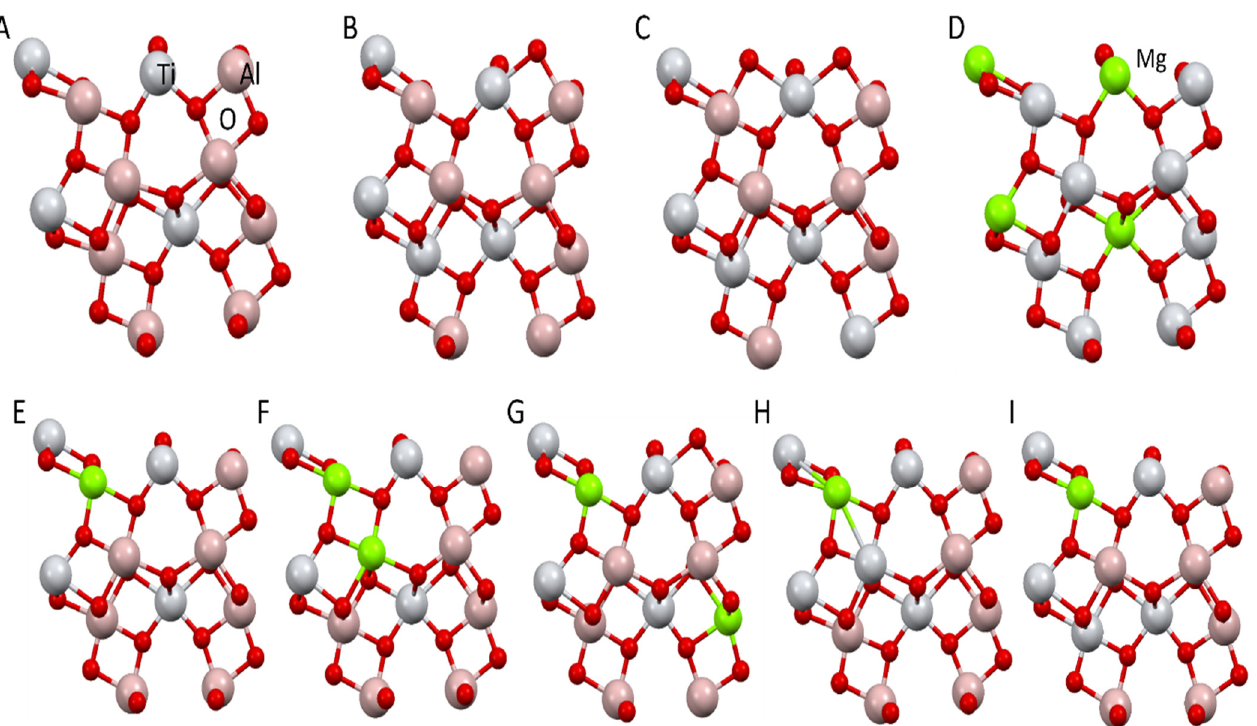
Figure 5. Unit cells with different compositions of Al 2 TiO 5 (numeration according to Table 3): ( A ) pure calculated by VASP, ( B ) with 1 Al exchanged for Ti, ( C ) with 2 Al exchanged for 2 Ti, ( E ) with 1 Al exchanged for Mg, ( F , G ) with 2 Al exchanged for 2 Mg, ( H , I ) with 2 Al exchanged for 1 Mg and 1 Ti, and ( D ) MgTi 2 O 5 . 1 Al exchange corresponds to the results for 9% exchange and 2 Al for 18%